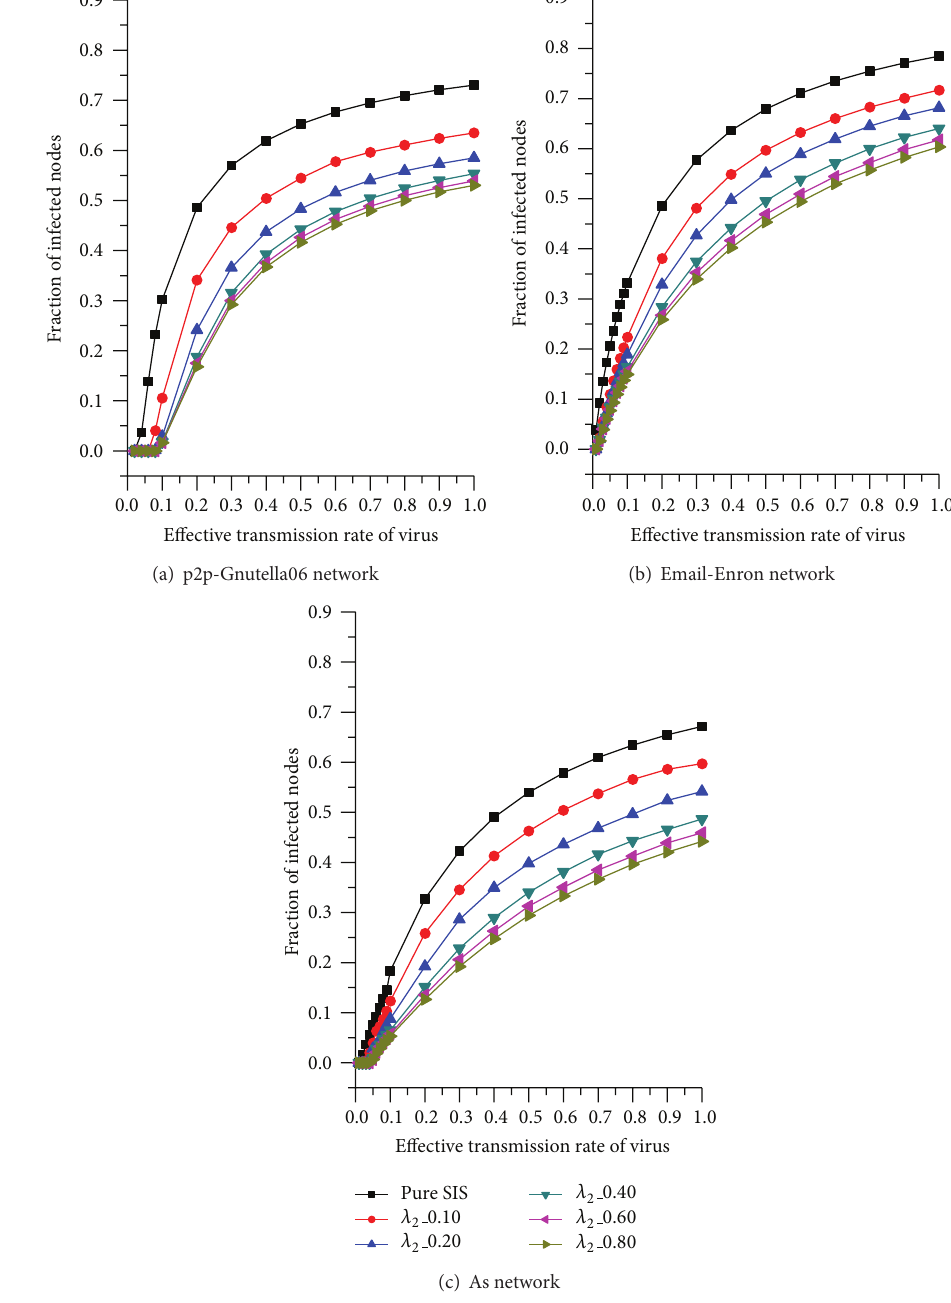
Substituting parameters of the finite size of BA network and (16) into (18) we